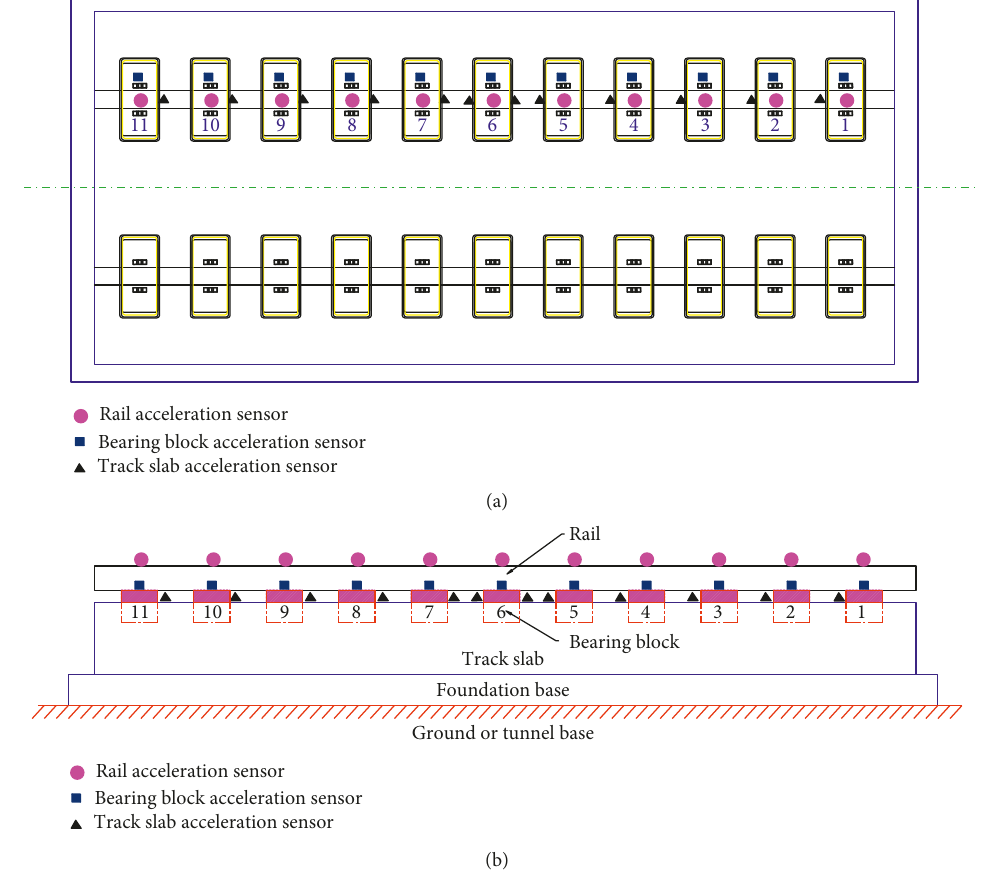
Figure 6: Vertical acceleration sensors arrangement along the track longitudinal line. (a) Top view. (b) Side